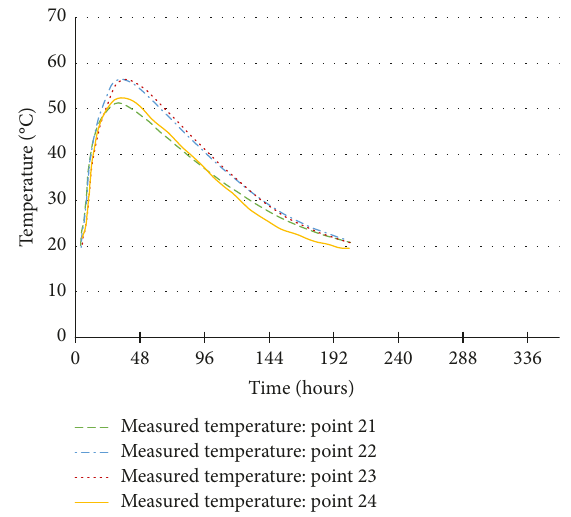
Figure 6: Measured temperature in the middle section (low-heat